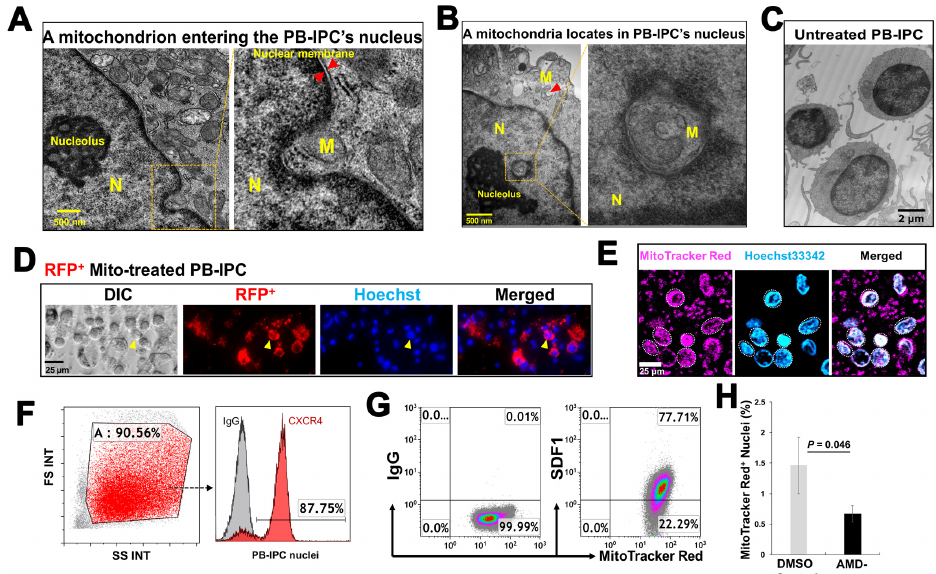
Figure 5. Penetration of mitochondria into nuclei of PB-IPC. ( A ) Transmission electron microscopy demonstrates a mitochondrion (M) crossing the nuclear membrane of a mitochondrion-treated PB-IPC. ( B ) A mitochondrion located inside the nuclear matrix, and close to the nucleolus with a morphologically-similar mitochondrion (indicated by red arrow) in the cytoplasm. ( C ) Ultrastructure of untreated PB-IPC. ( D ) Penetration of red fluorescent protein (RFP)-labeled mitochondria into PB-IPC. After PB-IPC were treated with RFP-labeled mitochondria for 4 h, confocal microscopy established RFP + mitochondria infiltrating the cytoplasm ( n = 5). Distribution of RFP + mitochondria inside of a nuclear was represented by an orange arrow. RFP + mitochondria (red) were colocalized with the Hoechst 33342-labeled nuclear (blue) and the differential interference contrast (DIC) image (left). ( E ) MitoTracker Red-labeled mitochondria (pink) entered nuclei (blue), and their colocalization was shown by confocal microscopy ( n = 5). Isolated mitochondria from platelets were co-cultured with purified nuclei of PB-IPC for 4 h in the presence of serum-free culture medium X-VIVO 15 at 37 °C and 5% CO 2 . ( F ) Expression of CXCR4 on the membrane of purified nuclei ( n = 4). ( G ) Mitochondria displaying CXCR4 ligand SDF-1 ( n = 4). ( H ) Blocking experiment with CXCR4 receptor antagonist